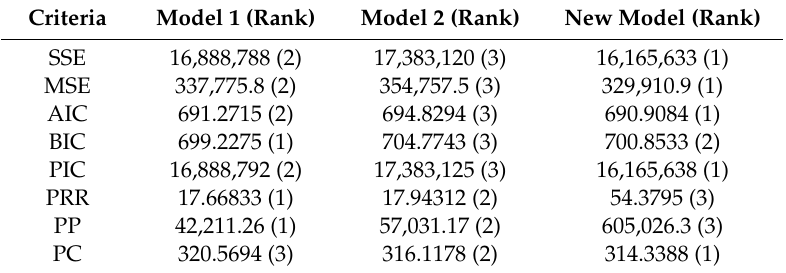
Table 5. Modeling results and rankings based on various criteria.